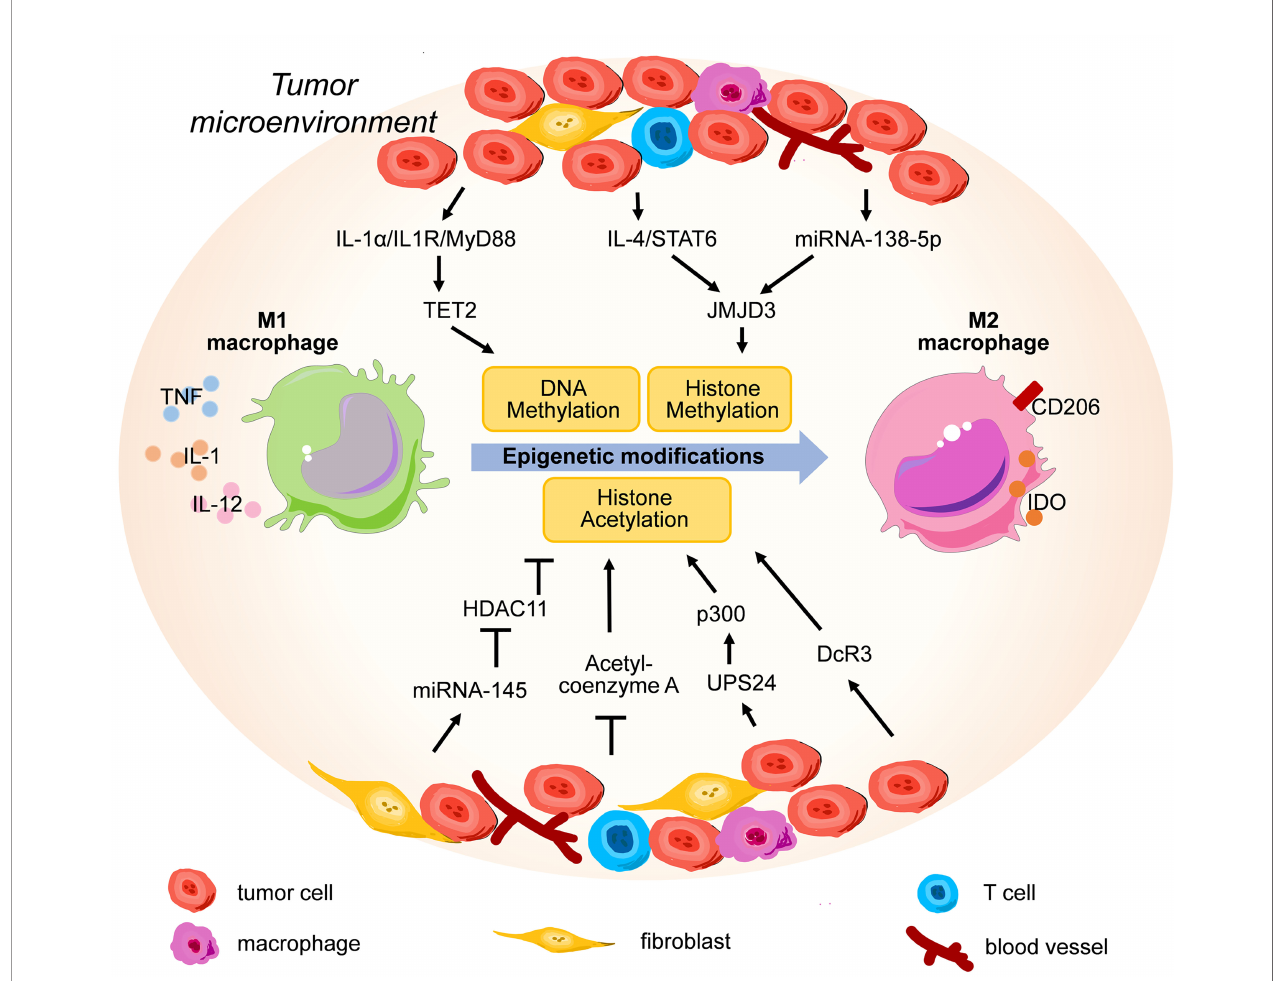
FIGURE 2 | The representative epigenetic signaling regulatory factors and pathways involved in modulating M2 polarization in tumor